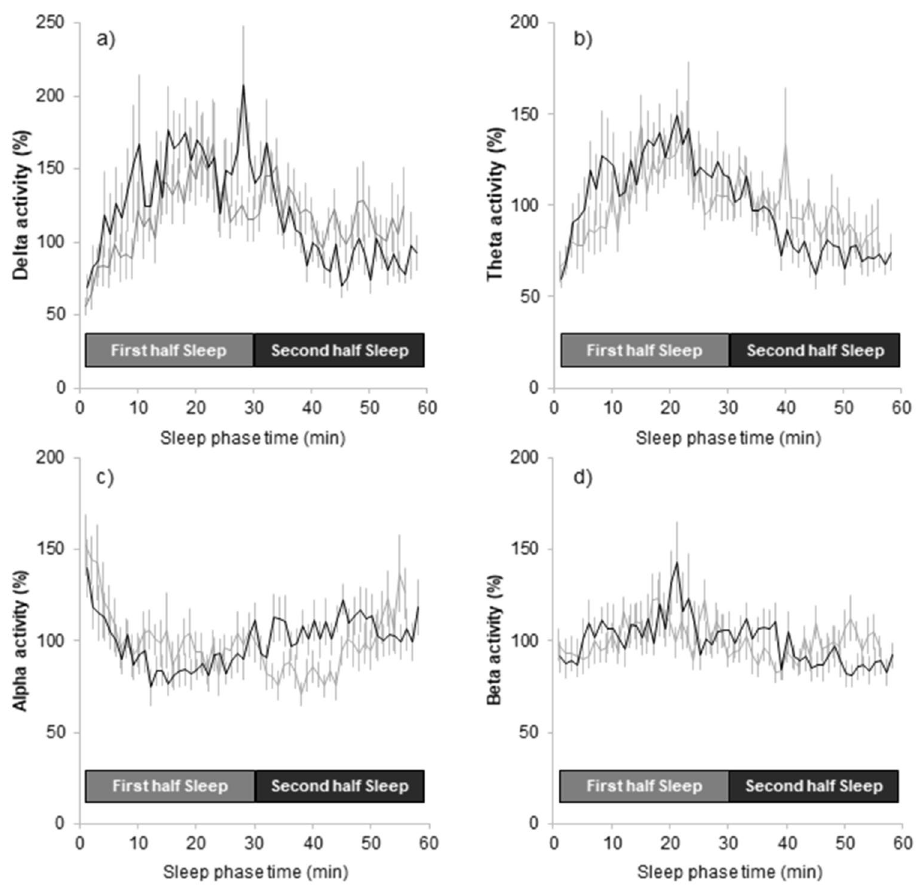
Figure 4. Time course of ( a ) delta activity (1.0–4.0 Hz), ( b ) theta activity (4.0–7.0 Hz), ( c ) alpha activity (8.0–12.0 Hz), and ( d ) beta activity (13.0–20.0 Hz) during the sleep session. Y axis represents the normalized values of each frequency based on the mean of each frequency during sleep session. All values are expressed as means ± SEM of eighteen subjects. The black line represents the warming condition, and the gray line represents the sham condition.